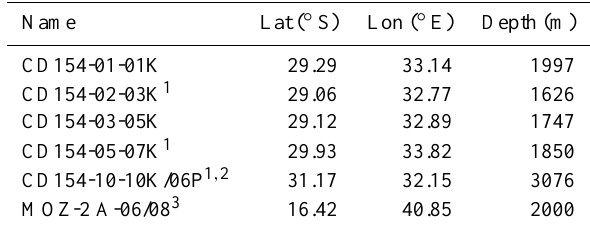
Table 1. Location of cores and moored sediment